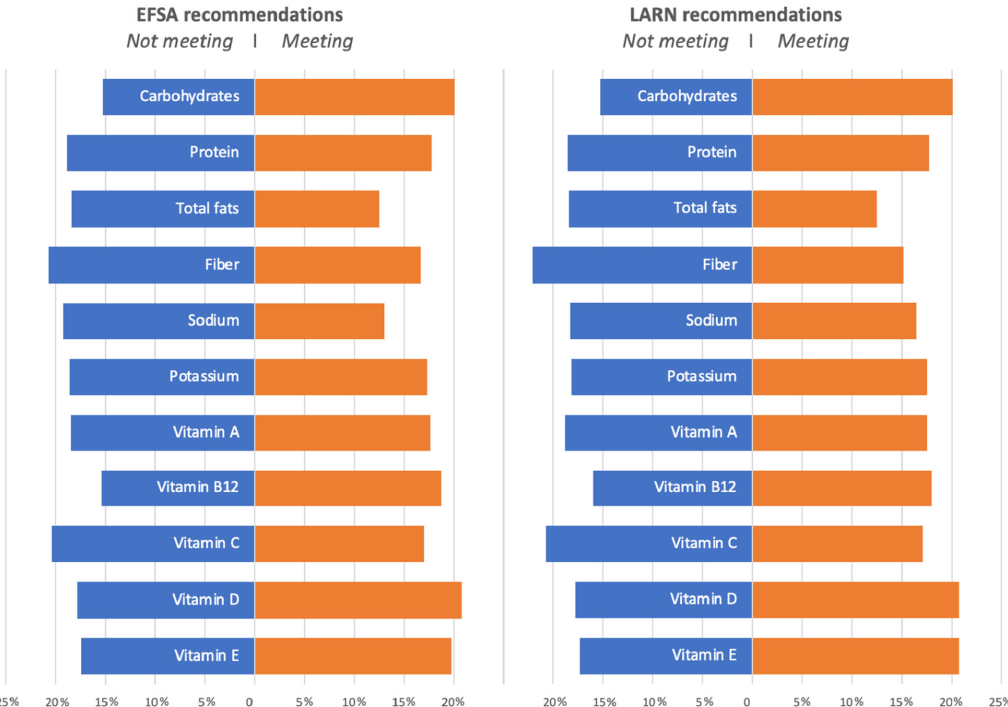
Figure 2. Percentage of UPF consumption in individuals meeting and not meeting the European and Italian nutritional recommendations for selected macro- and micro-nutrients. Finally, the energy shares of NOVA food groups by level of adherence to various dietary patterns and indices of diet quality is shown in Figure 3: irrespectively of the dietary score used, individuals displaying a “healthier” dietary profile (meaning higher adherence to either the Mediterranean diet, the DASH diet, the A ‐ HEI, or the DQI ‐ I) consumed less UPFs and more unprocessed/minimally processed foods, with minor variation in the other NOVA food categories (Figure 3). Detailed data are reported in Supplementary Table S5.